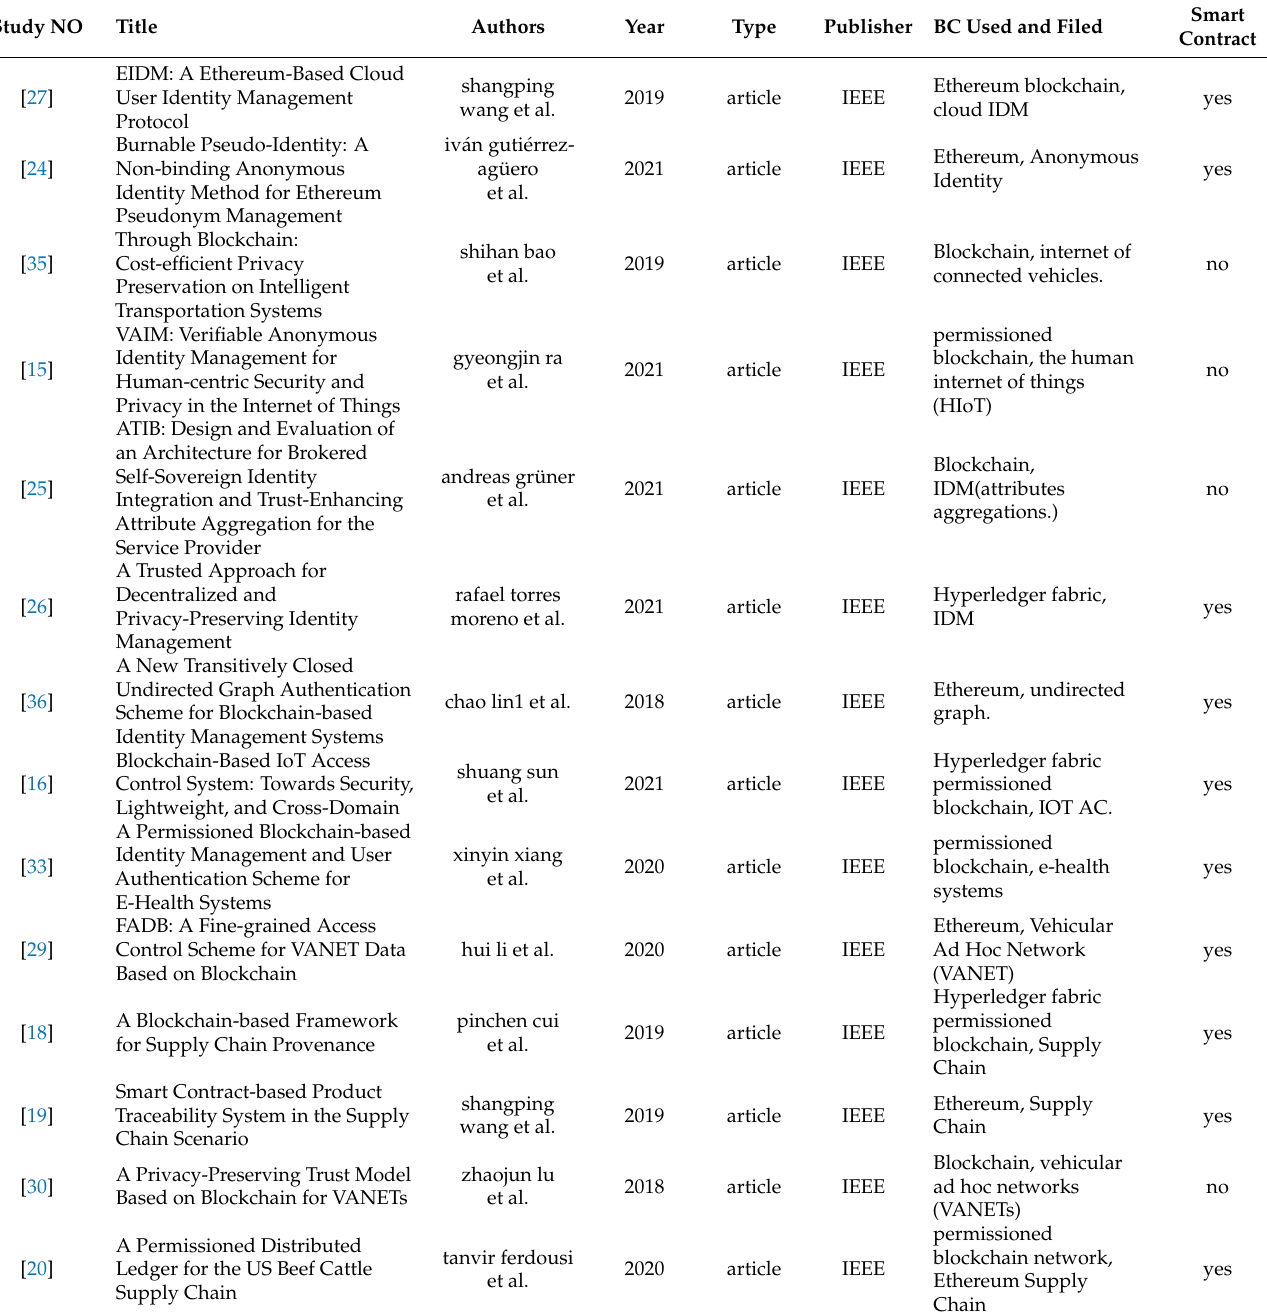
Table A2. IEEE Included